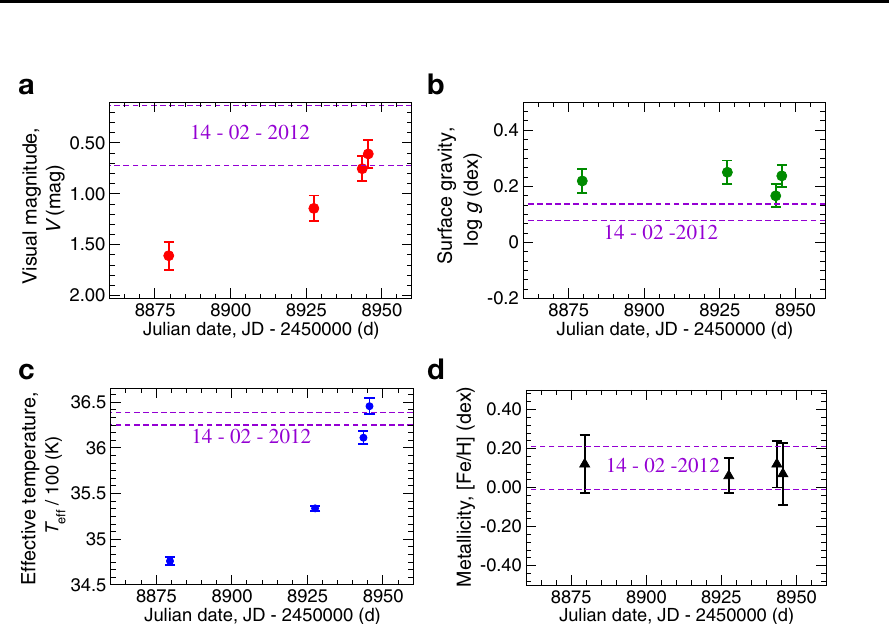
Fig. 1 The mean visual magnitude ( V ), surface gravity (log g ), effective temperature ( T eff ), and metallicity ([Fe/H]) of Betelgeuse obtained on 2020 January 31, March 19, April 4, and April 6. a Each V magnitude was calculated by averaging over all available magnitudes in the AAVSO database in a particular date of observations. b The uncertainty of surface gravity (log g ) is taken as the difference between the 84th and 50th percentile as the upper limit, and the difference between the 50th and 16th percentile as the lower limit. c The uncertainty of the effective temperature ( T eff ) is taken as the difference between the 84th and 50th percentile as the upper limit, and the difference between the 50th and 16th percentile as the lower limit. d Metallicity ([Fe/H]) was calculated by averaging over all iron abundances from individual lines in a particular date of observations. The two horizontal dashed lines show the ranges of parameters ( V , T eff , log g , [Fe/H]) for pre-dimming, which we have obtained with ESPaDOnS ’ s spectrum observed on 2012 February, 14. Error bars represent standard deviation. Source data are provided as a Source Data fi